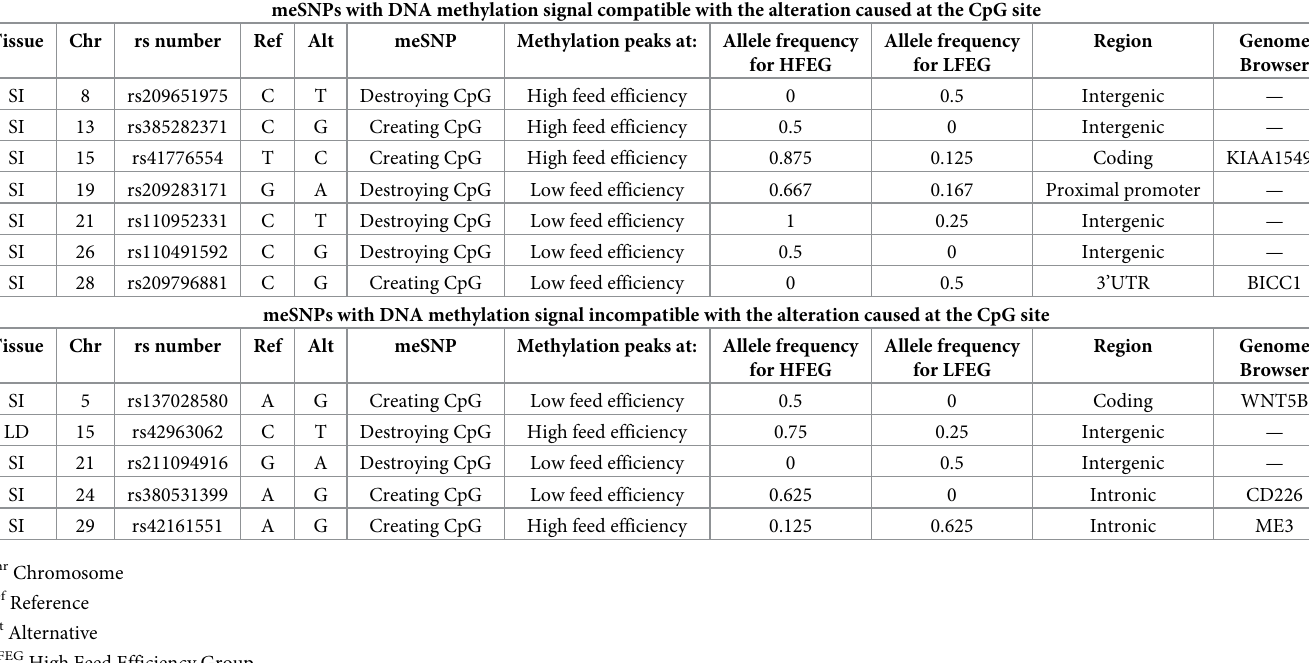
Table 3. meSNPs responsible for changes in genomic sequence associated with variation in feed efficiency in cattle. meSNPs with DNA methylation signal compatible with the alteration caused at the CpG